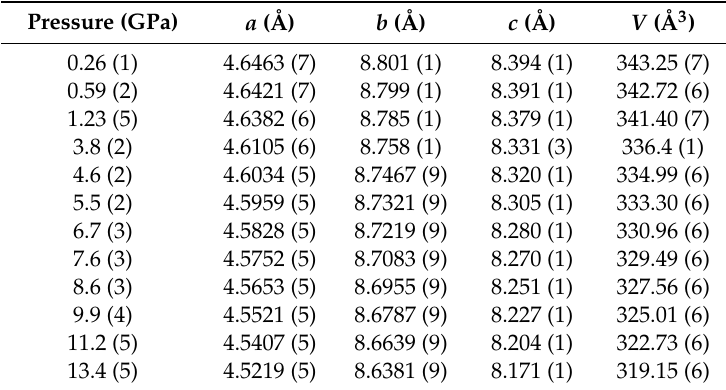
Table 1. The unit–cell parameters of topaz at high